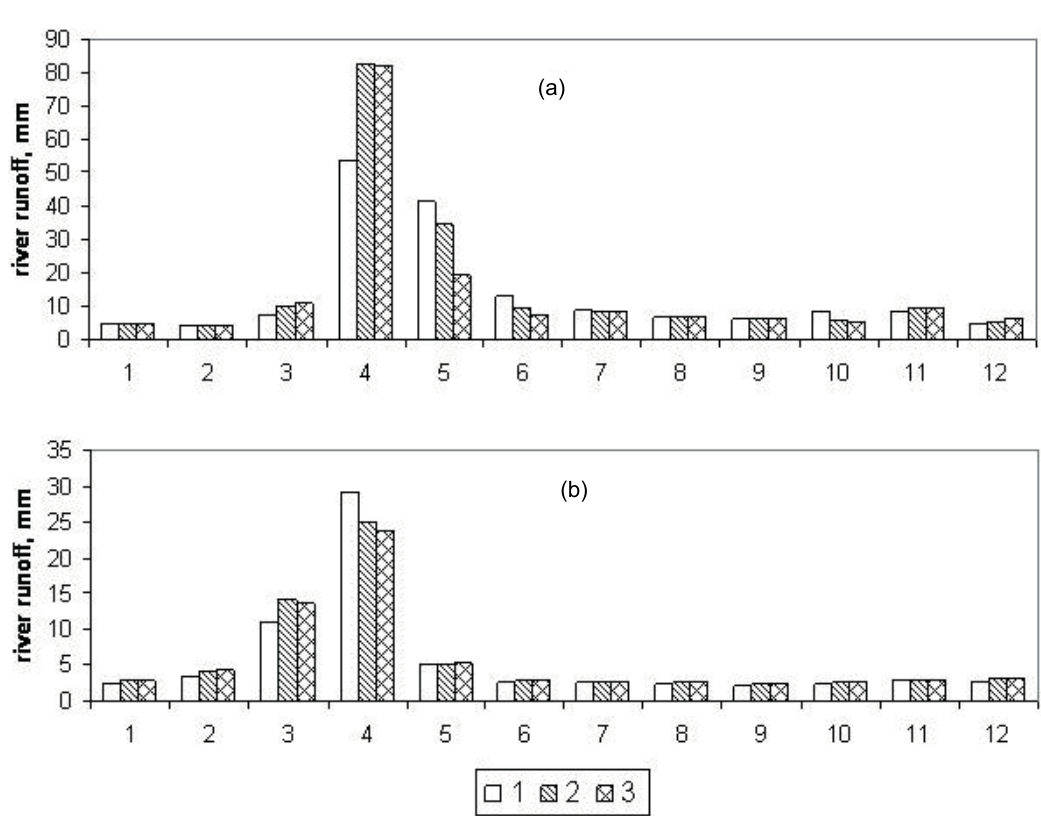
Fig. 3 Hydrographs of monthly runoff depths: observed runoff (1) and runoff under climatic A2 (2) and B1 (3) scenarios averaged over regular grid cells for the Volga (a) and Don (b) river